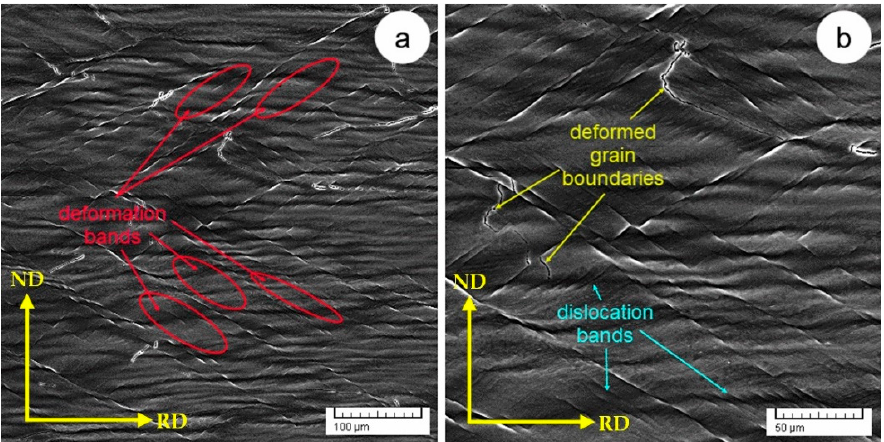
Figure 6. Microstructure of the CR TNTZ alloy at different magnifications (×200—( a ); ×400—( b )).